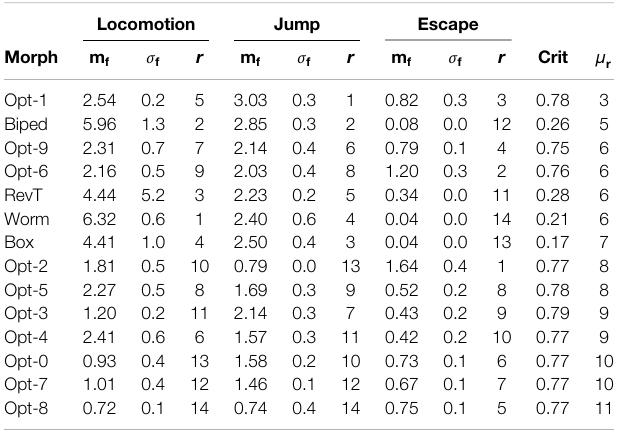
TABLE 1 | Results for the optimized and handcrafted morphologies coupled with thephasecontroller.Foreachtaskandeachmorphology,thetableshowsthe median m f and the standard deviation σ f of f across all the 10 runs. Moreover, the table also shows the task-wize ranks r , the average rank μ r , and the criticality of each morphology.